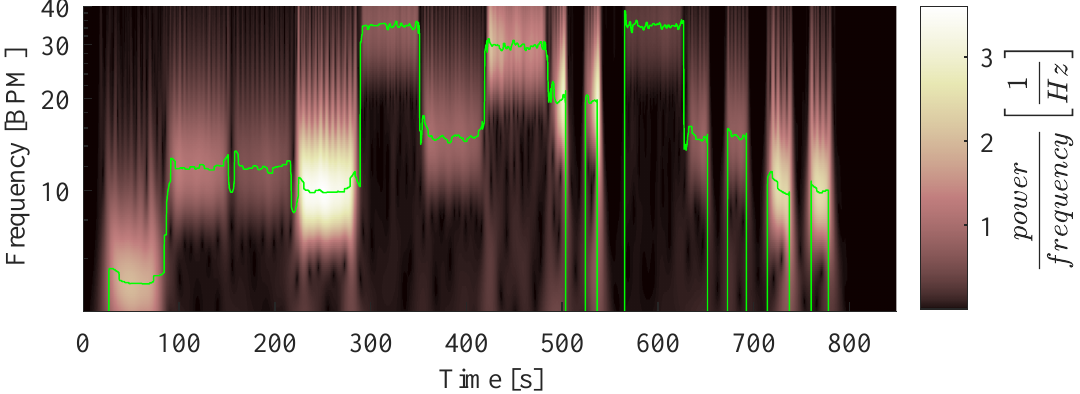
Figure 8. Continuous wavelet spectrum of the mean RGB signal, including the extracted respira- tory